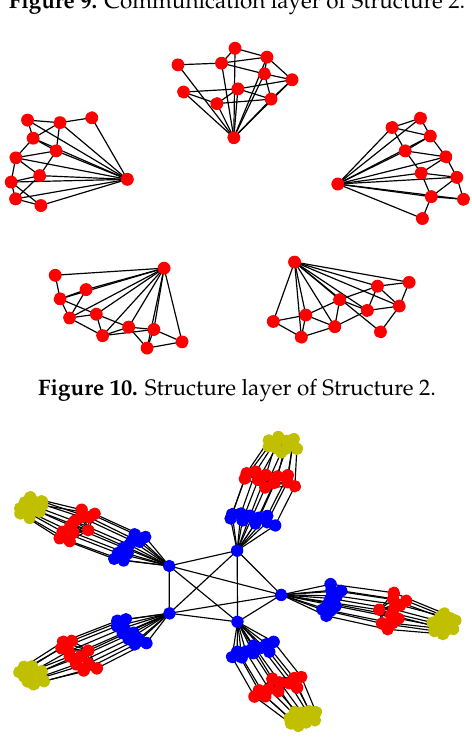
Figure 9. Communication layer of Structure 2.